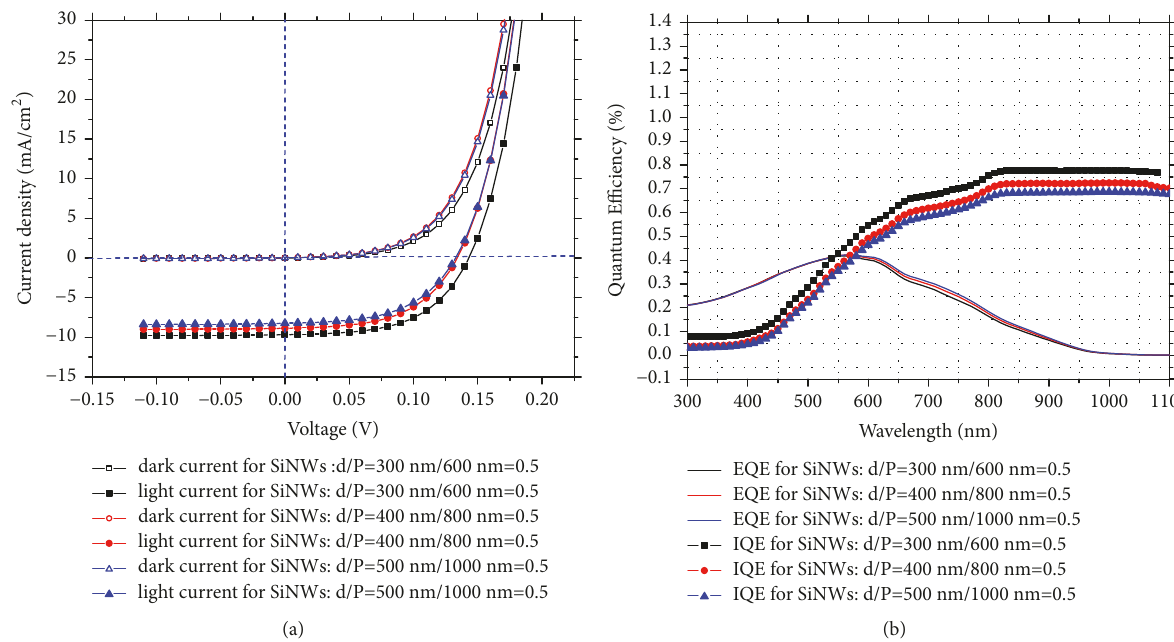
Figure 6: Photovoltaics performance of nanowires radial p-n junction solar cell versus diameter: ( a ) J-V curves for 0.3 𝜇 m, 0.4 𝜇 m, and 0.5 𝜇 m; ( b ) EQE and IQE for 0.3 𝜇 m, 0.4 𝜇 m, and 0.5 𝜇 m,